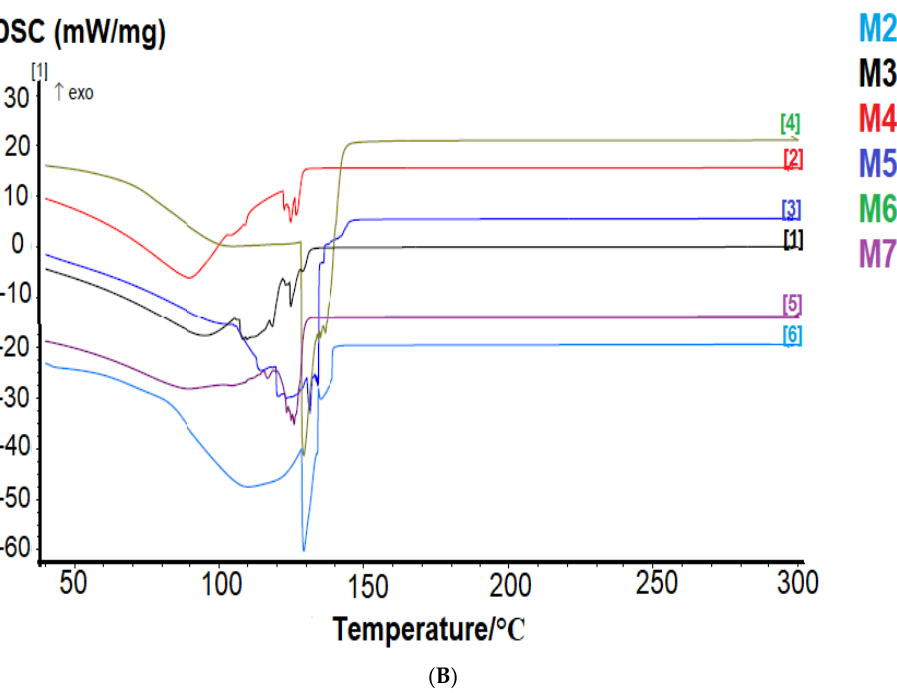
Figure 4. Differential scanning calorimetry (DSC) thermograms of ( A ) ( 1 ) F127: Pluronic ® F127, ( 2 ) F68: Kolliphor ® P188, ( 3 ) PRD: prednisolone, and ( 4 ) PM: physical mixture; and ( B ) M 2 − 7 microgels.